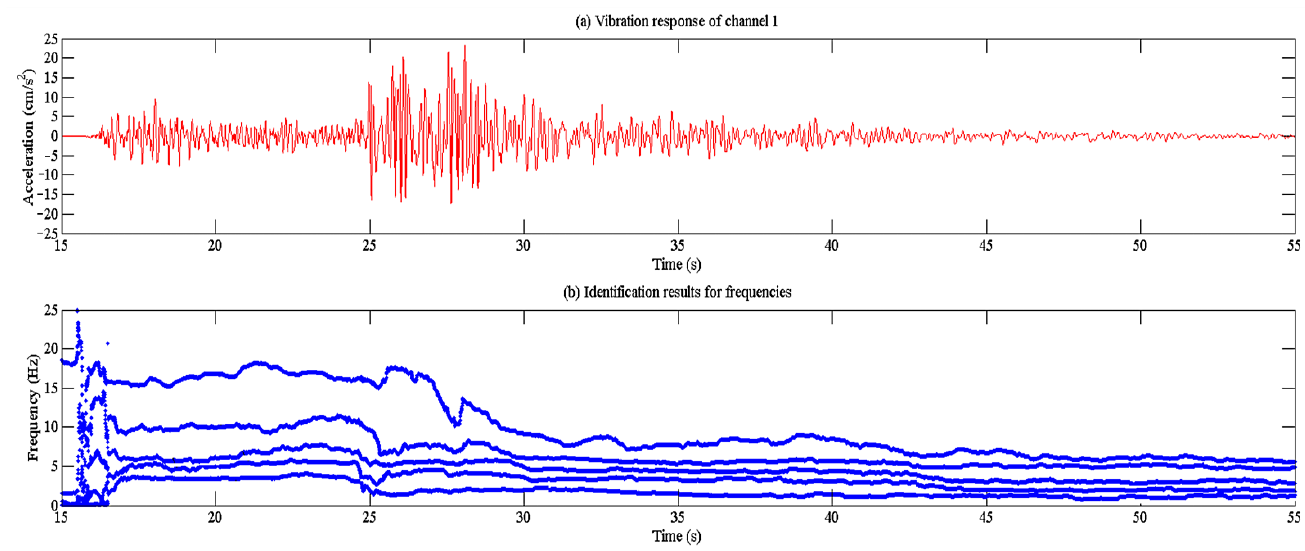
Figure 12. Variation in the structural frequency of the Pacoima Dam identified by the RSSI method during the San Fernando earthquake in